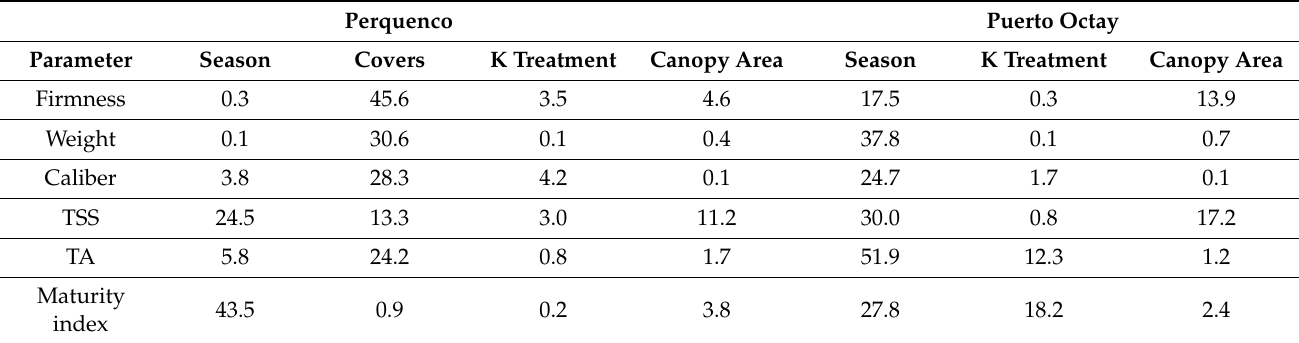
Table 2. Percentage (%) of variance explained by the effect of the independent variables for the most relevant fruit quality parameters of sweet cherry (cultivar Regina) cultivated in two commercial orchards located in southern Chile (Perquenco and Puerto Octay), subjected to two foliar potassium (K) treatments: conventional K regime (4 sprays during the season: K- treatment) or intensive K regime (7 sprays during the season; K+ treatment). In each location, the assays were conducted in two consecutive seasons. In the Perquenco orchard, covered and un-covered trees were compared. Abbreviations: TSS (total soluble solids); TA (titratable acidity); MI (maturity index). Puerto